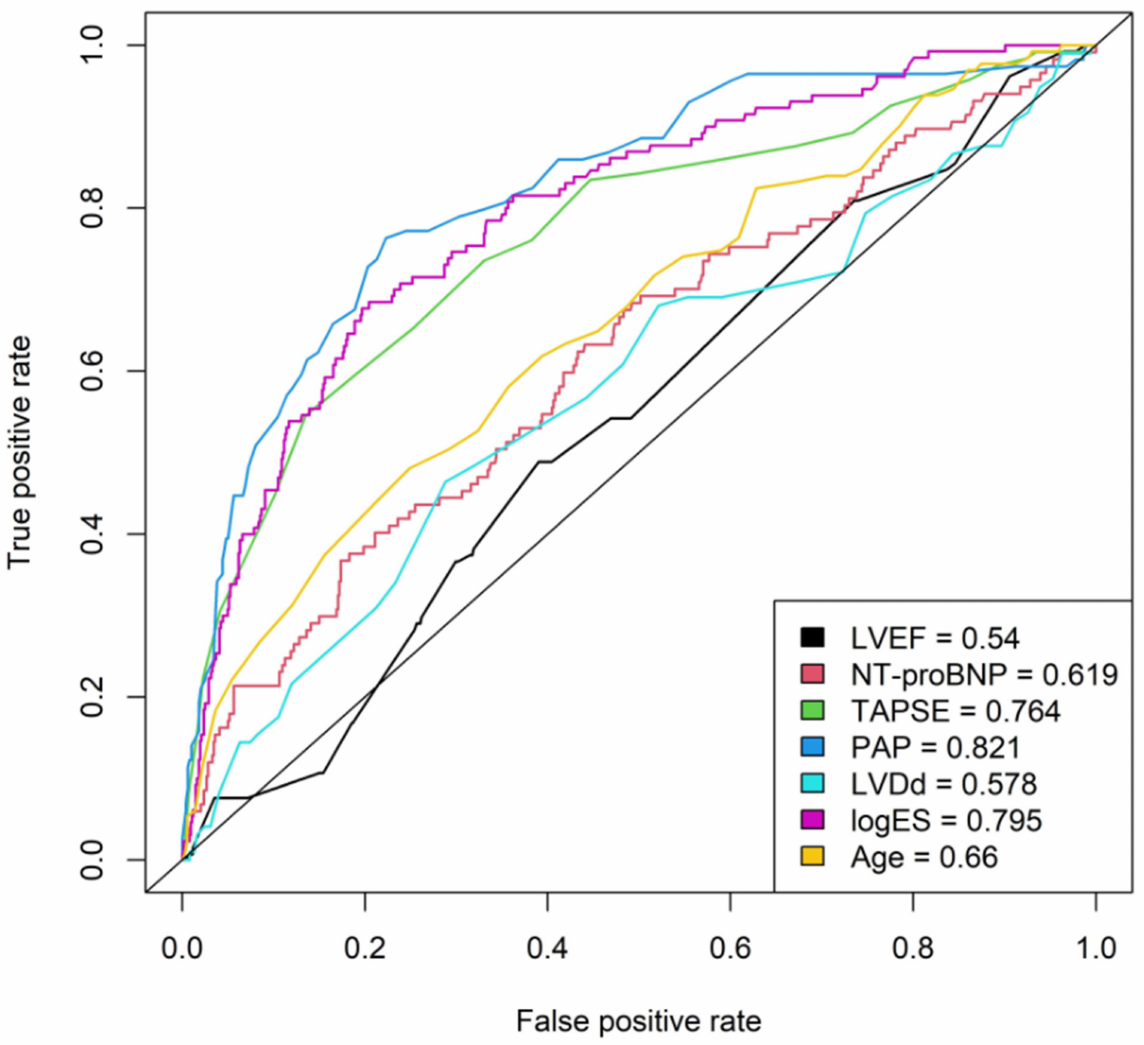
Figure 1. AUC: area under curve, EF: left ventricular ejection fraction, NT-proBNP: N-terminal prohormone of brain natriuretic peptide. TAPSE: tricuspid annular plane systolic excursion, PAP: pulmonary artery pressure, LVDd: diastolic diameter of left ventricle, logES: logistic